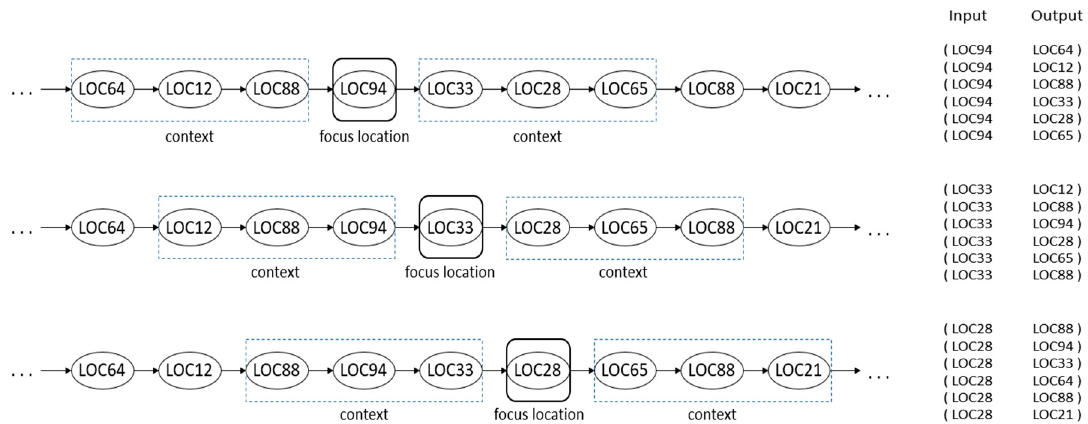
Figure 4. The process of sliding window (with a length of three locations in the past and three in the future) and the model input–output pairs.